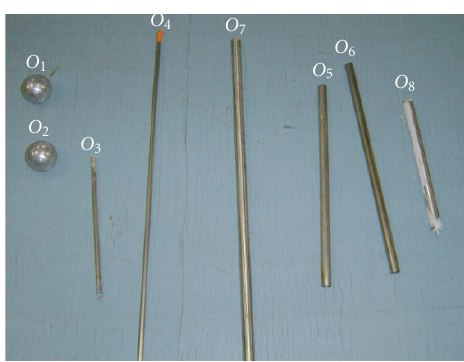
Figure 4: Objects.